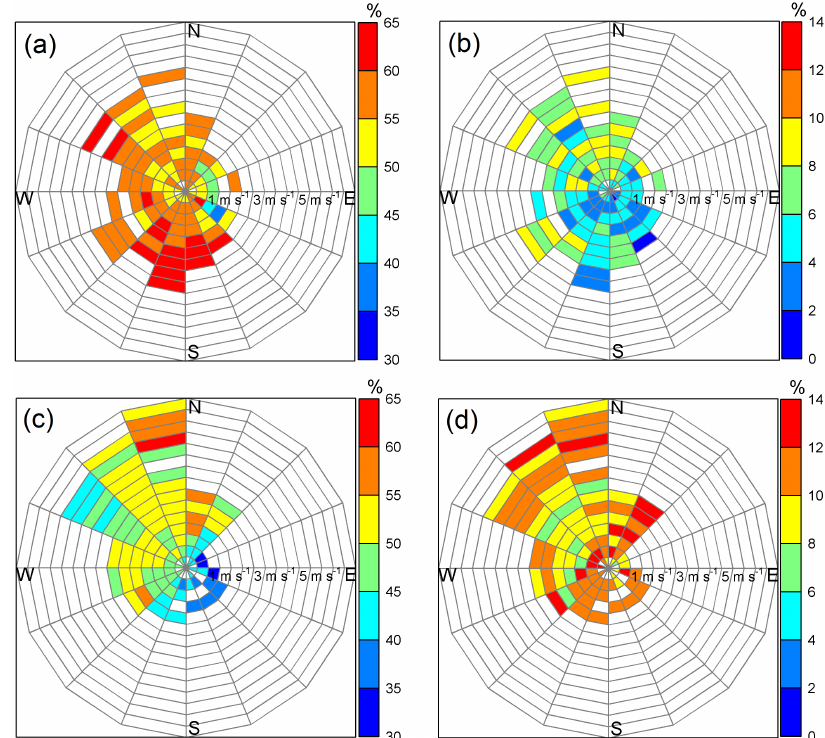
Figure 6. Wind dependency map of VECs to NO 2 and PM 2 . 5 in July (a, b) and December (c, d) 2013. Wind speeds are shown from 0 to 7.5ms − 1 .